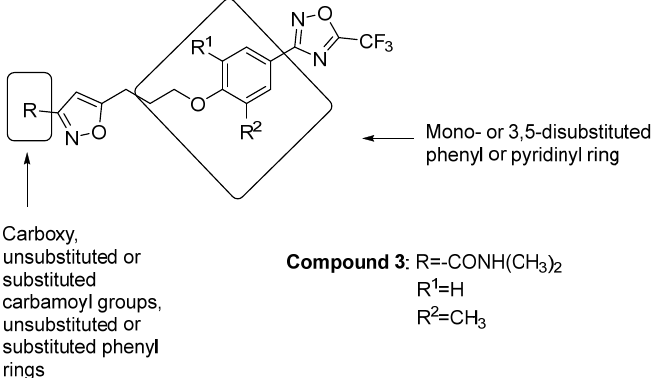
Figure 5. SAR studies on pleconaril analogues and chemical structure of compound 3 .